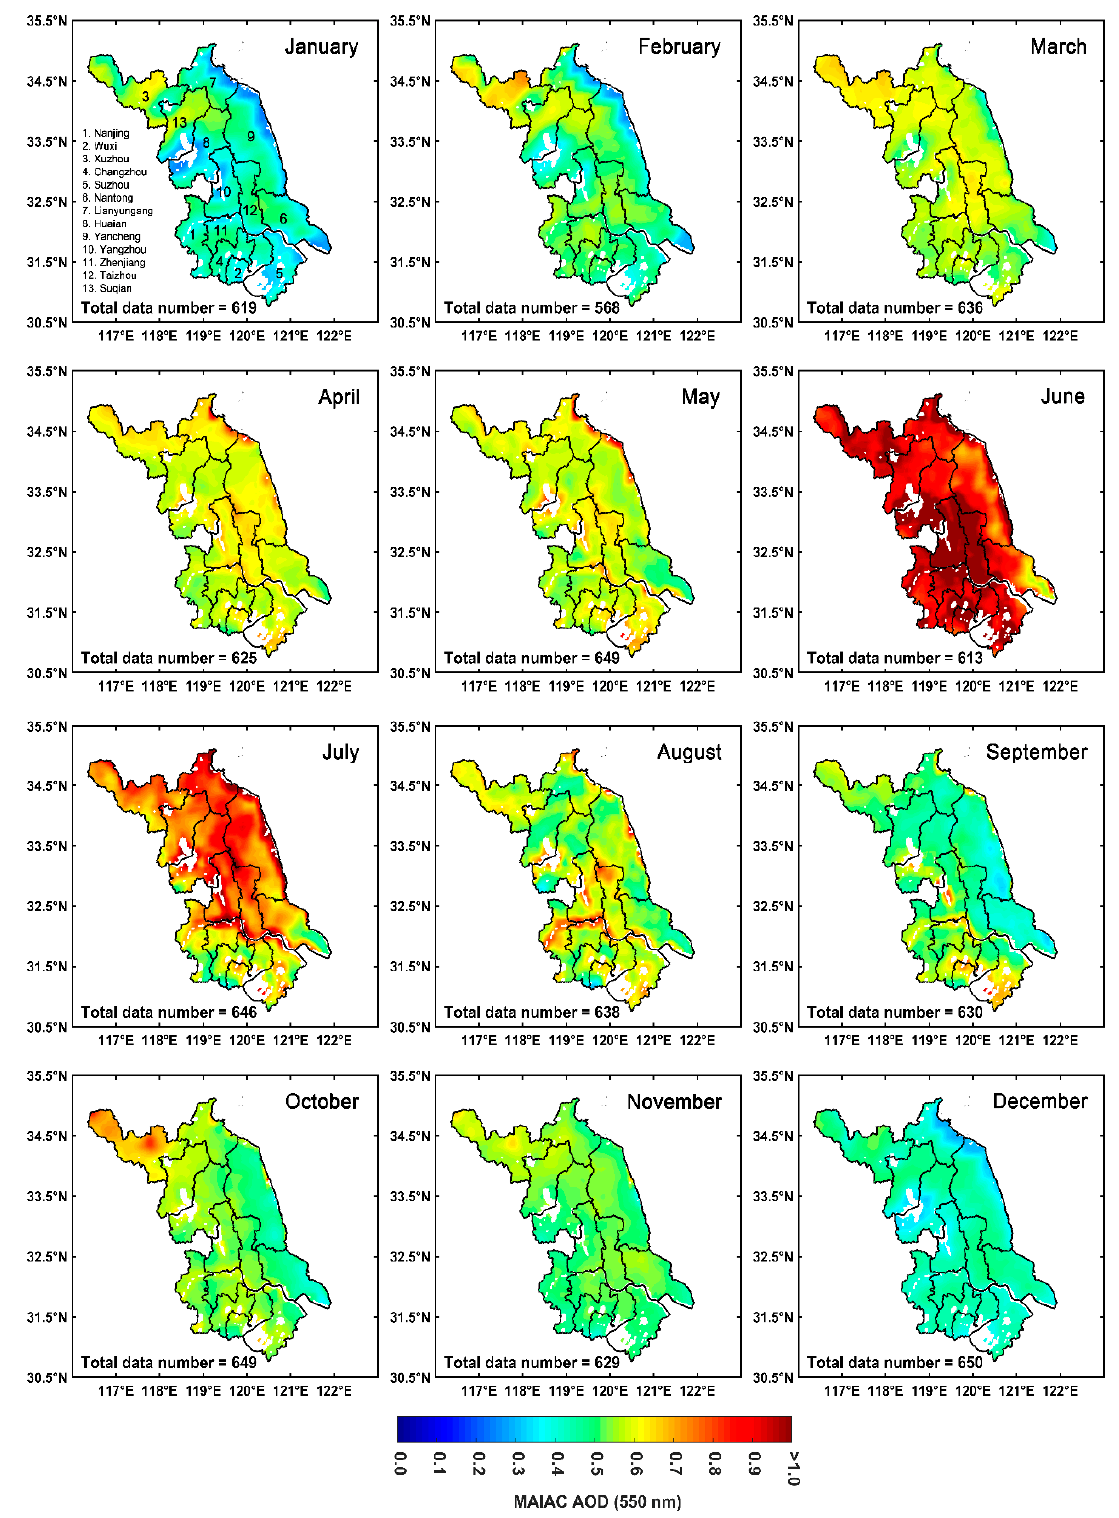
Figure 5. Monthly spatial distribution of high-resolution MODIS MAIAC AOD over Jiangsu Province from 2000 to 2020.